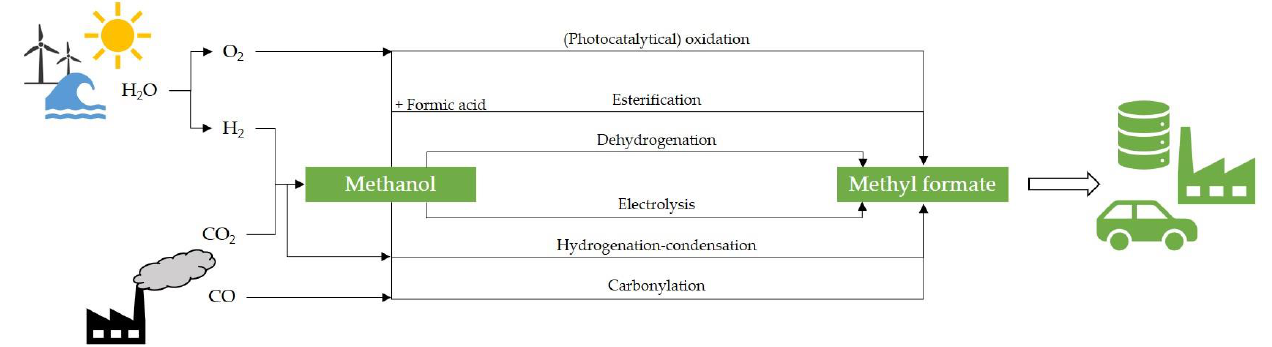
Figure 6. Possible synthesis routes of methyl formate from green methanol.